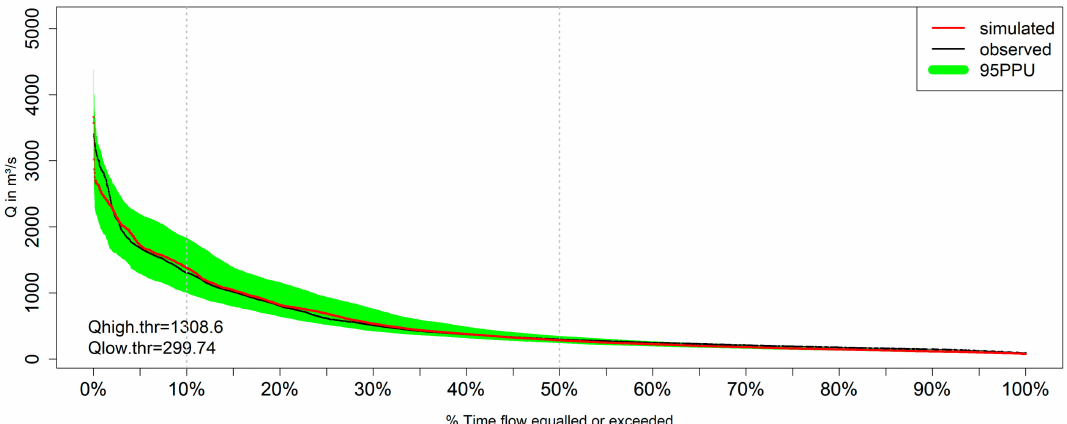
Figure 5. Flow duration curve for the simulated and observed discharge for the simulation period (1958–1970). Additionally, the 95PPU is illustrated, which represents the modeling uncertainty by showing the cumulative distribution of flow between the 2.5th and 97.5th percentiles of all the simulation solutions. Statistical measures for the ranked simulated and observed values are 0.99 for R 2 and NSE , respectively.